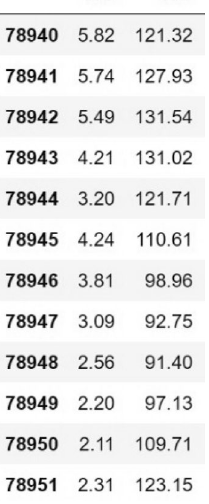
Fig. 28 Target values of wind speed and